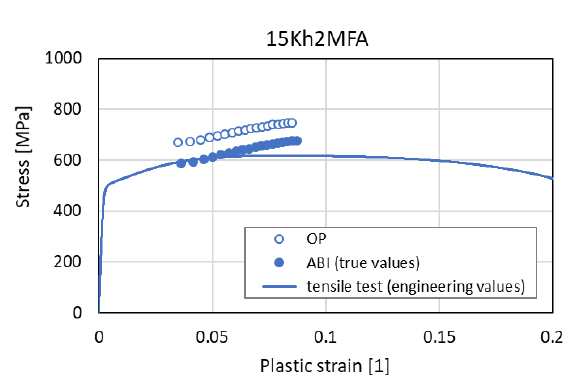
Figure 4. Stress/plastic strain curves for 15Kh2MFA steel obtained by various techniques.